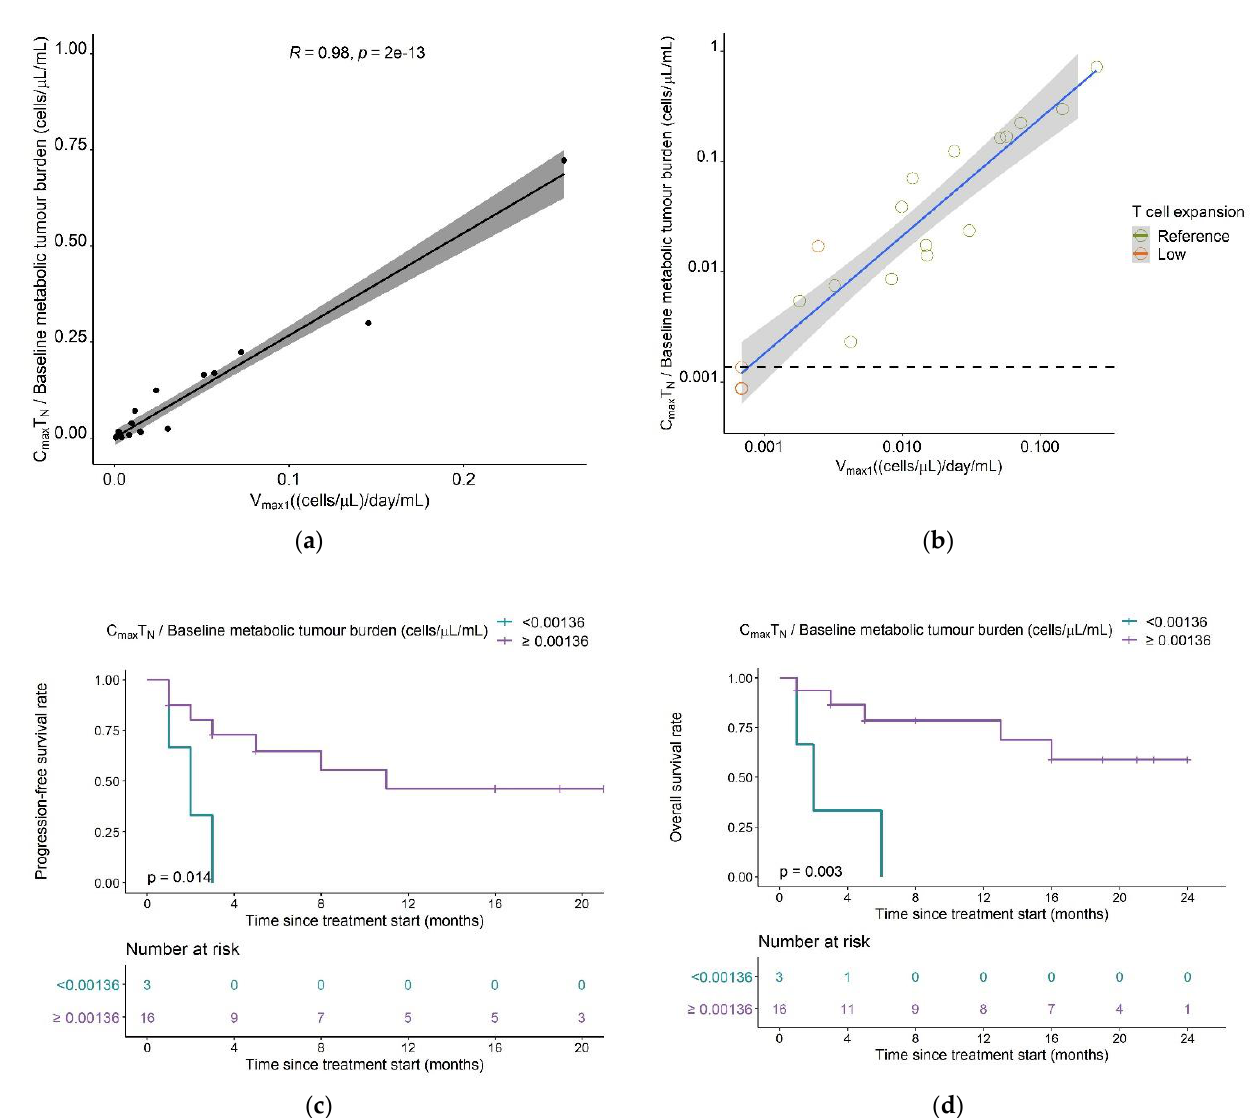
Figure 9. Determination of a clinical composite score (CCS) cut-off value for early response-prediction. ( a ) Correlation between model parameter V max1 ((cells · µ L − 1 ) · day − 1 · mL − 1 ) and CCS Maximum naïve CAR-T cell concentration/Metabolic tumor volume at baseline ((cells · µ L − 1 ) · mL − 1 ). ( b ) Correlation plot as A but on a log-log scale and different labeling of the T cell expansion subpopulation. The dashed horizontal line marks the CCS cut-off value most predictive for allocation to the low expansion subpopulation, as determined using ROC analysis. ( c ) Kaplan–Meier probabilities for progression-free survival in patients below or exceeding the determined CCS TN cut-off value. ( d ) Kaplan–Meier plots for overall survival in patients below or exceeding the determined CCS TN cut-off value. Abbreviations—CCS TN : clinical composite score for naïve CAR-T cells.